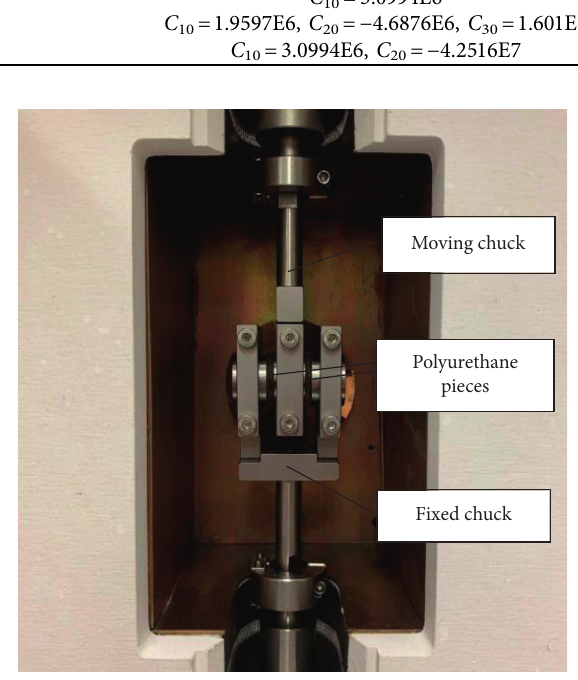
Figure 5: Frequency scanning test of double-shear specimen.